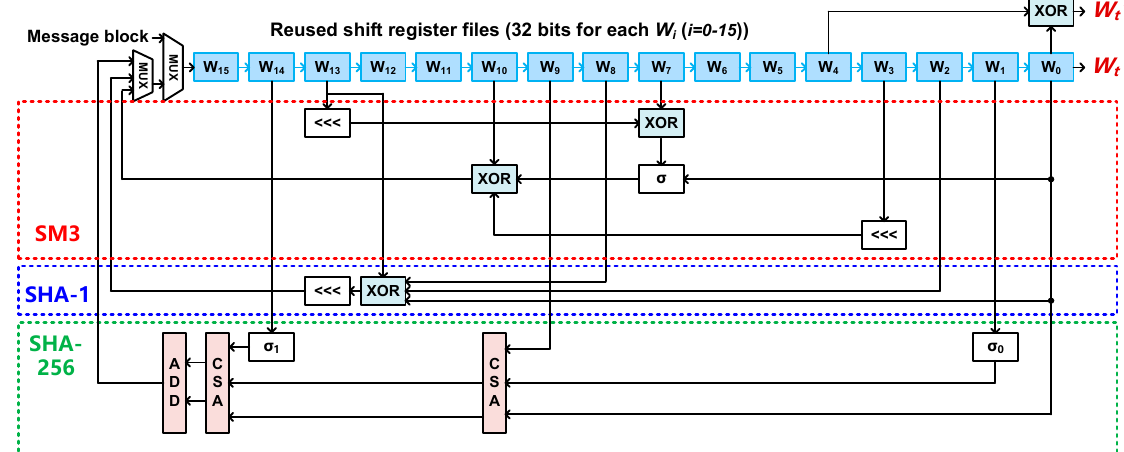
Figure 9. Hardware architecture of message expansion module in the reconfigurable hash unit.